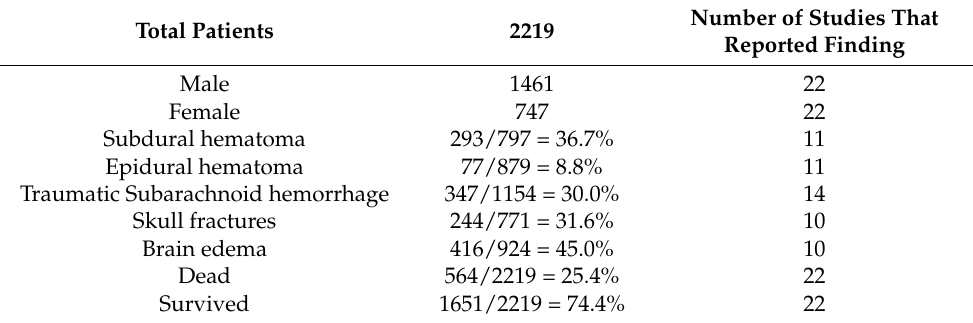
Table 2. Demographic data, prevalence of imaging findings, and outcome in all 22 studies. Total